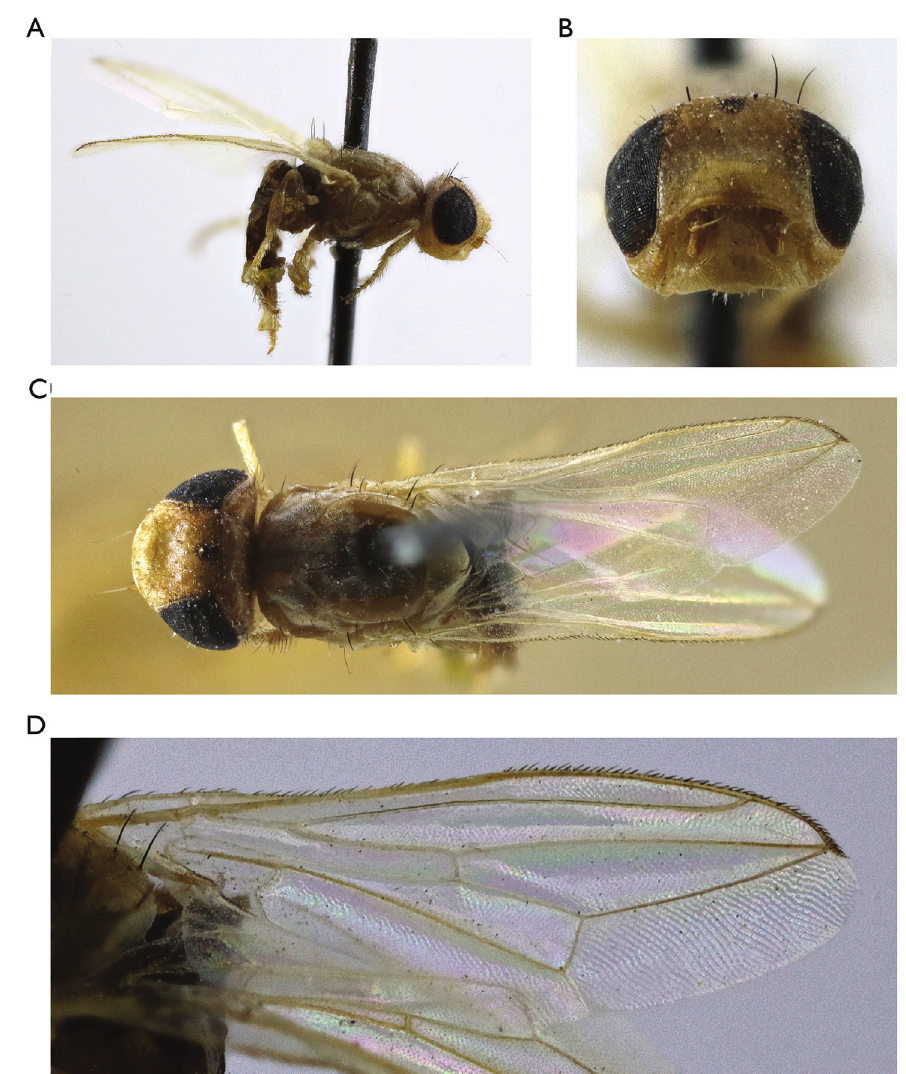
Figure 7. Timia flaveola Galinskaya, 2011, paratype male A habitus, lateral view B head, anterior view C head and thorax, dorsal view D